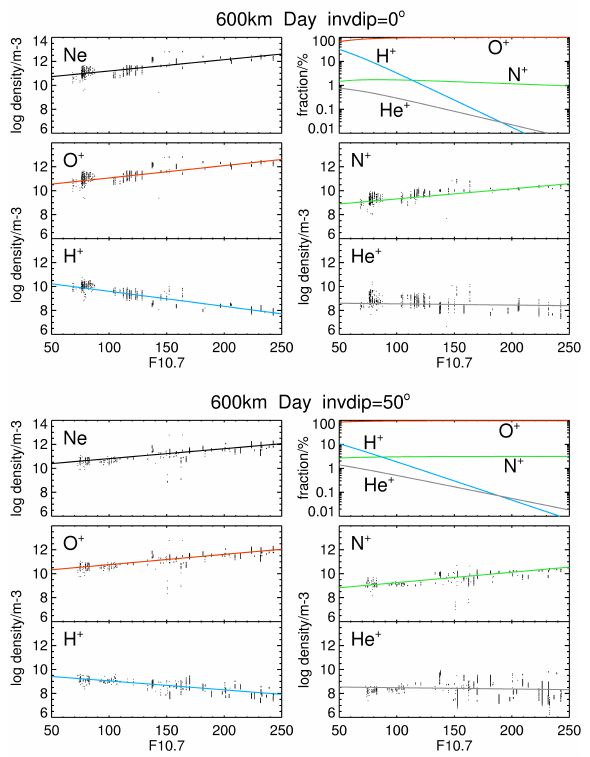
Fig. 4. Dependence of the logarithm of the individual ion densities, of the electron (=total ion) density, and of the relative ion densi- ties on the solar activity level characterized by the actual day val- ues of the F10.7 index. Example for equinox, equator ± 15 ◦ , mid- latitudes 50 ◦ ± 15 ◦ , altitude of 600 ± 80km, and nighttime 0 ± 3h MLT. Points-measured values, lines-values calculated from the models (TTS relative ion density and electron density